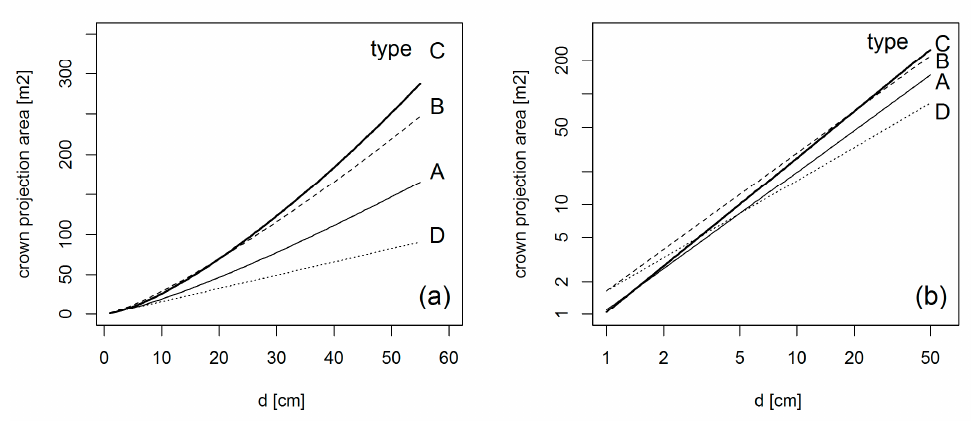
Figure 2. Allometric relationship cpa = a × d α cpa,d for four basic types of crown development shown in ( a ) linear and ( b ) double-logarithmic representation. The curves A–D correspond with the size and shape development from young to mature trees shown in Figure 3.